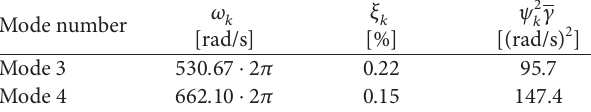
Table 7: Identified modal